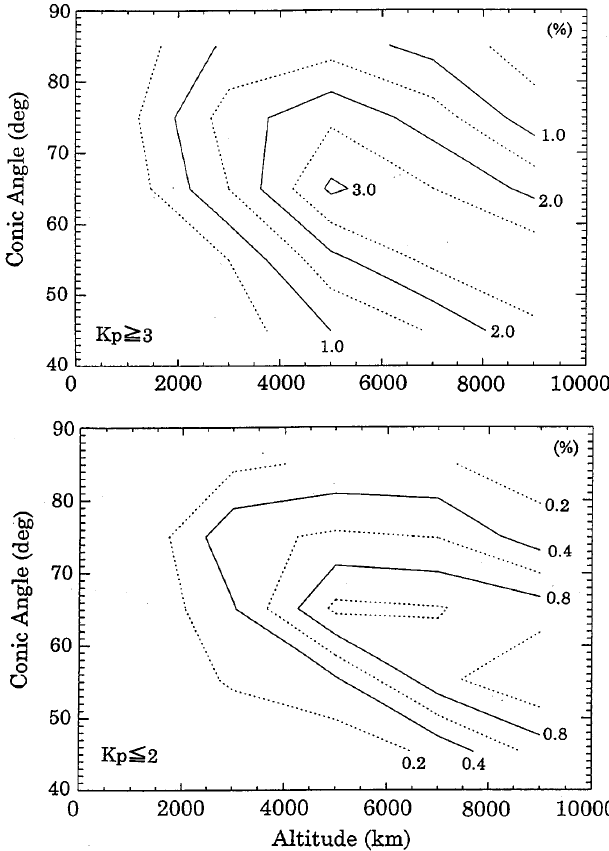
Fig. 2. The contour of the occurrence frequencies of standard ion conics as a function of altitude and conic angle observed in the cusp/ cleft region at geomagnetically active ( upper panel ) and quiet intervals ( lower panel